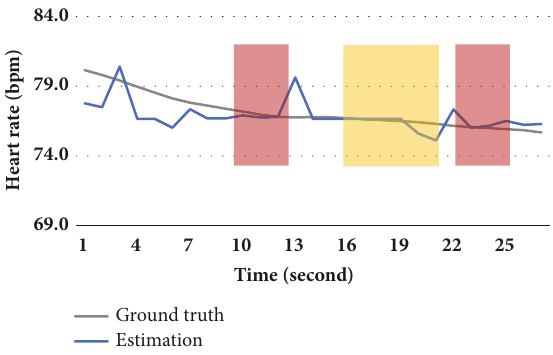
Figure 5: Heart rate trend between estimation and ground truth on challenging driving course. Red box: speed bump. Yellow box: rapid illumination change.